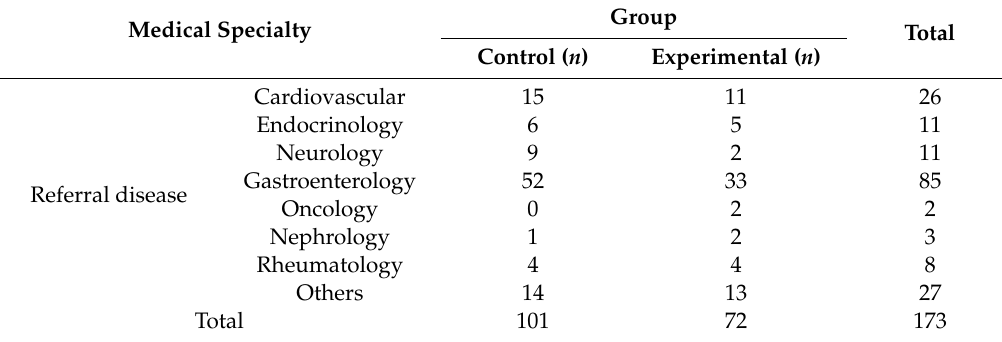
Table 3. Frequency of referral diseases by groups.